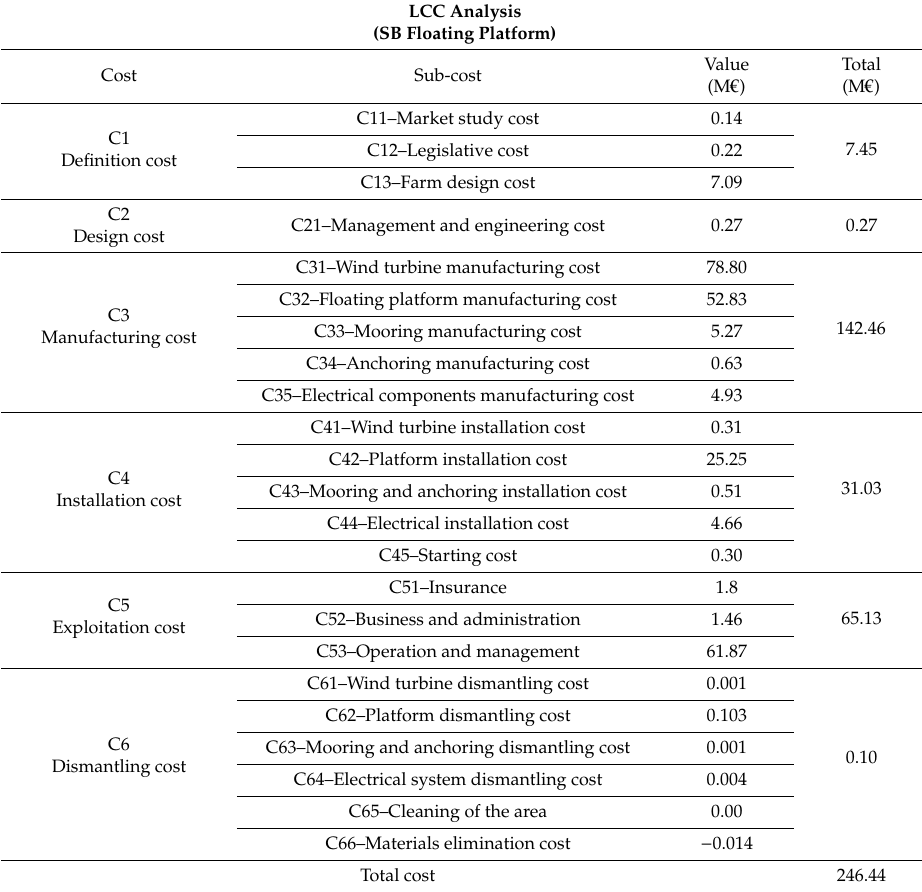
Table 5. LCC analysis for FOWF with SB platform.